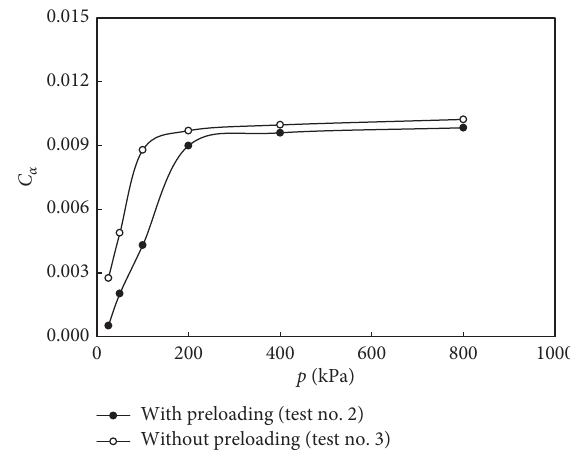
Figure 8: The effect of preloading on the relationship between the secondary consolidation coefficient and the consolidation pressures.